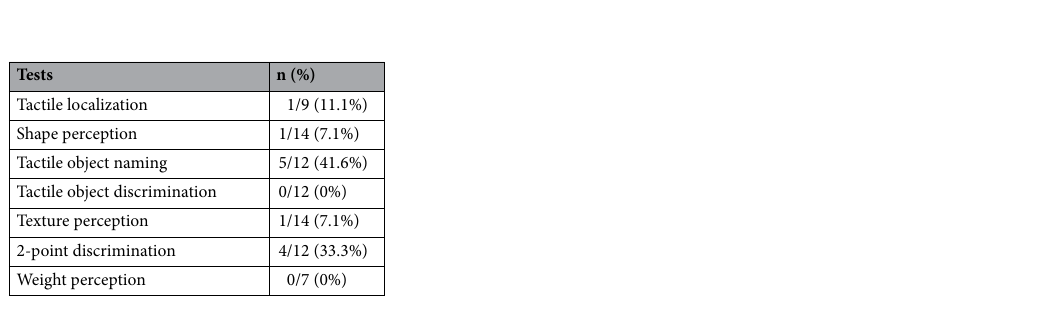
Table 4. Number of cases significantly different between unaffected and affected sides in the CBS group. The denominator represents the number of cases that could be tested, and the numerator represents the number of cases that were significantly